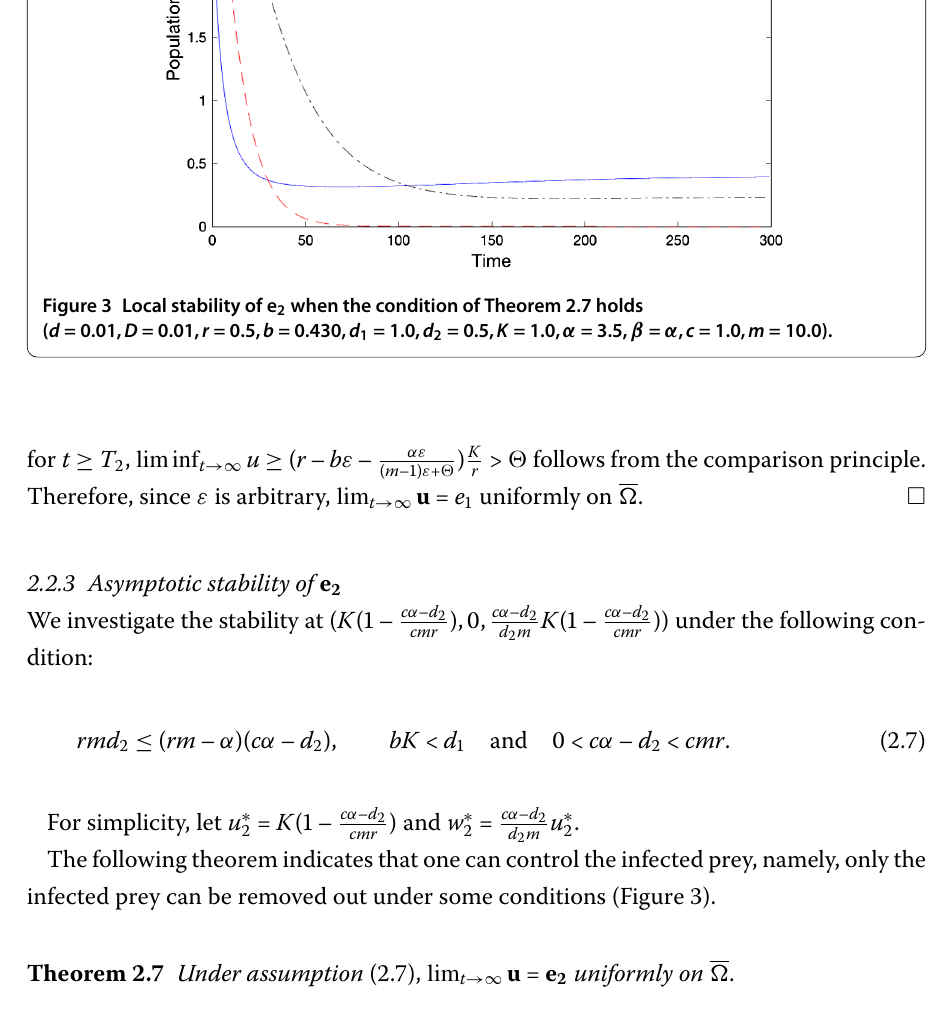
for t ≥ T  , liminf t →∞ u ≥ ( r – b ε – αε